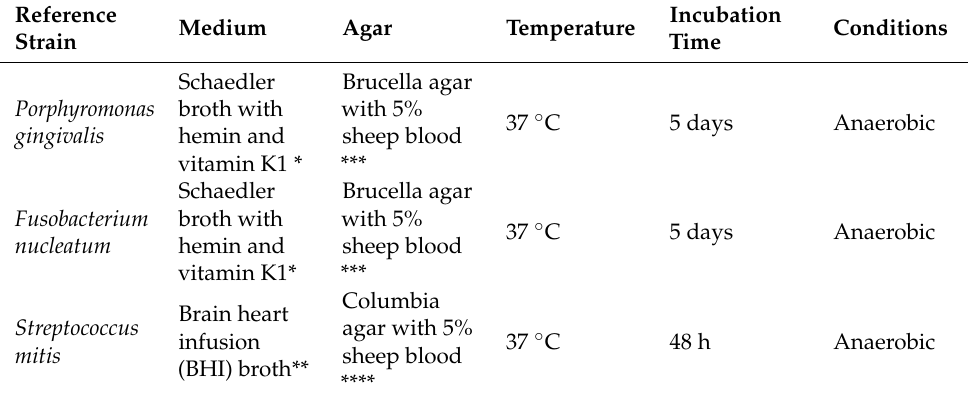
Table 2. Growing conditions of reference strains: Porphyromonas gingivalis ATCC 33277, Fusobacterium nucleatum ATCC 25586, and Streptococcus mitis ATCC